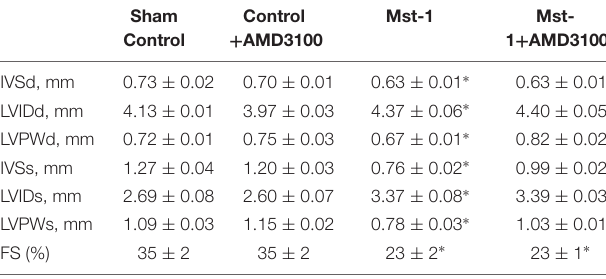
TABLE 2 | Echocardiographic